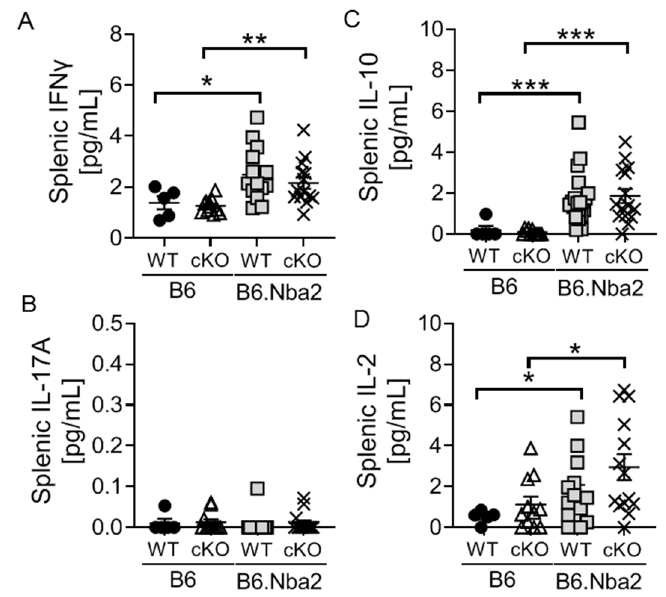
Figure 3. Intrasplenic levels of cytokines are dysregulated in B6.Nba2 mice independent of T-cell specific IFNAR expression. IFNAR-sufficient and -deficient female B6 and B6.Nba2 mice were analyzed for levels of intrasplenic cytokines: IFN γ ( A ), IL-17A ( B ), IL-10 ( C ), and IL-2 ( D ) as described in Materials and Methods. Each symbol represent one mouse. n = 4–5 (B6), n = 11 (B6 cKO), n = 14 (B6.Nba2), n = 9 (B6.Nba2 cKO). * p < 0.05; ** p < 0.01; *** p < 0.001, Student’s unpaired t -test with Welch’s correction.